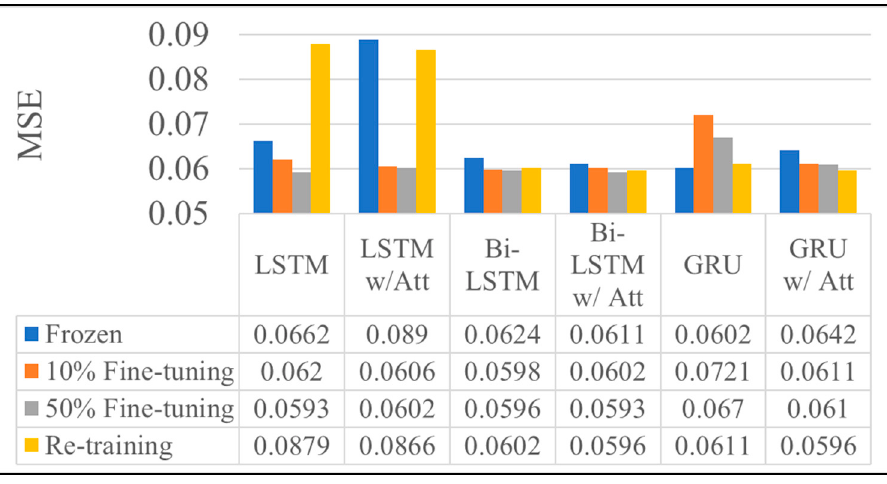
Figure 16. MSE of the target disease course prediction of TL-CDC without attention mechanism under k = 3.